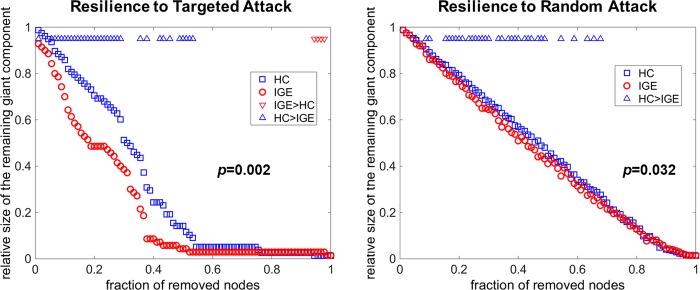
Assessments of network resilience to random failure or targeted attack.Triangles indicate significant differences between the control and IGE groups. Additionally, the displayed p-values were calculated based on AUC comparisons.